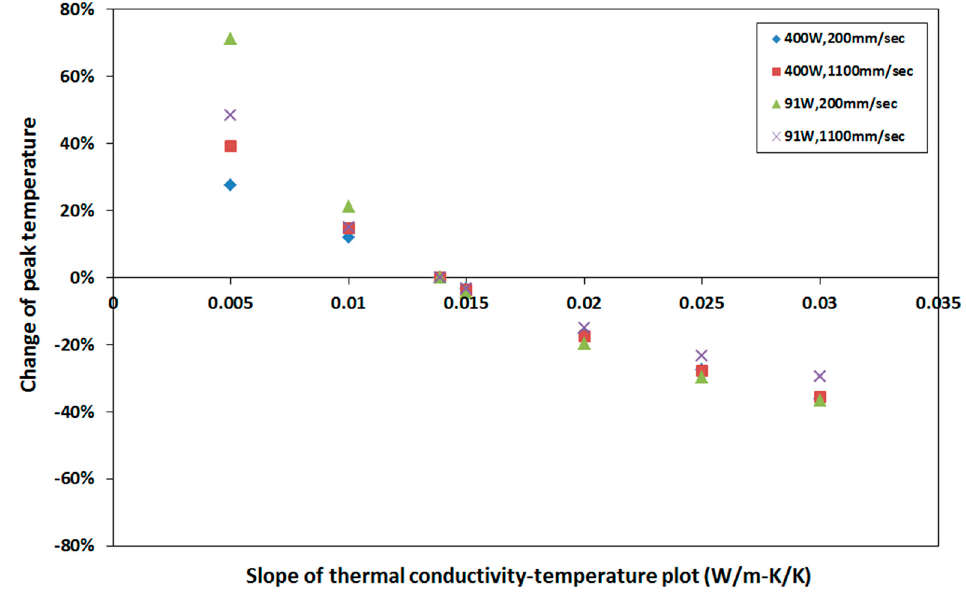
Figure 15. Sensitivity of peak temperature to thermal conductivity. Percentage change of peak temperature with respect to that calculated with base thermal conductivity at different process parameters .